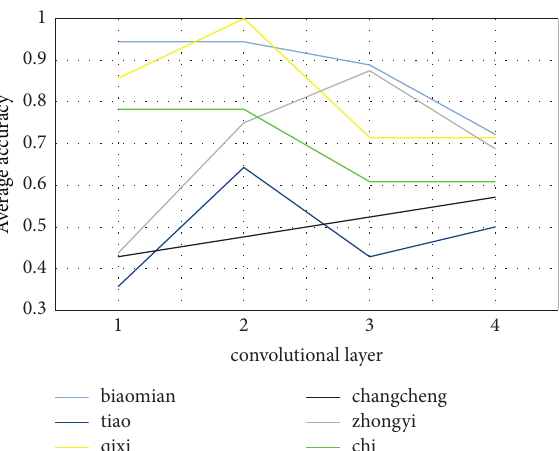
Figure 7: Accuracies under different layer